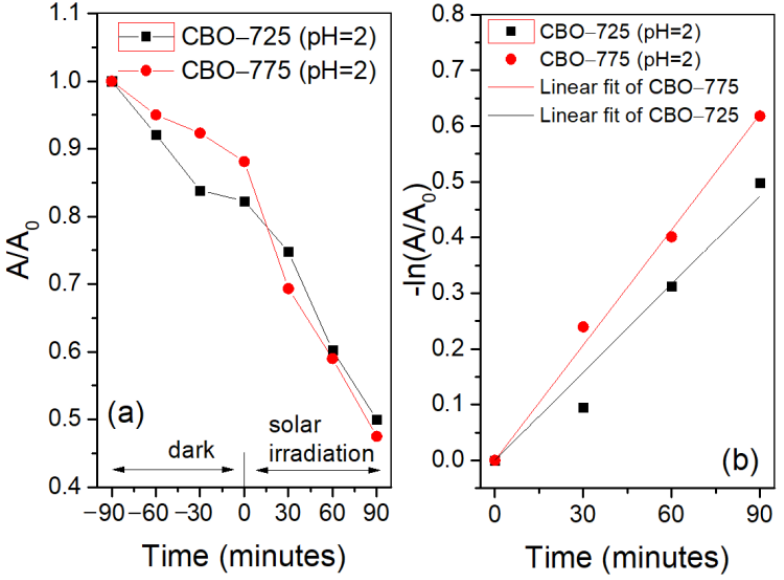
Figure 10. ( a ) RhB removal curves for CBO-725 and CBO-775 at pH = 2 and ( b ) the corresponding pseudo-first order kinetic curve.